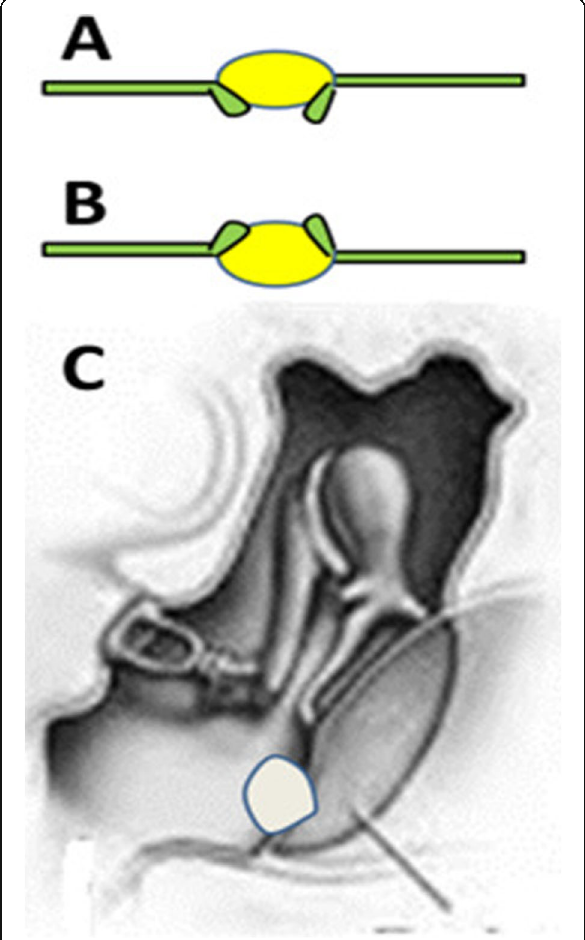
Fig. 1 Steps of fat graft insertion: a inward inversion of the perforation edges, b the graft is mobilized out everting edges, and c Fat graft in